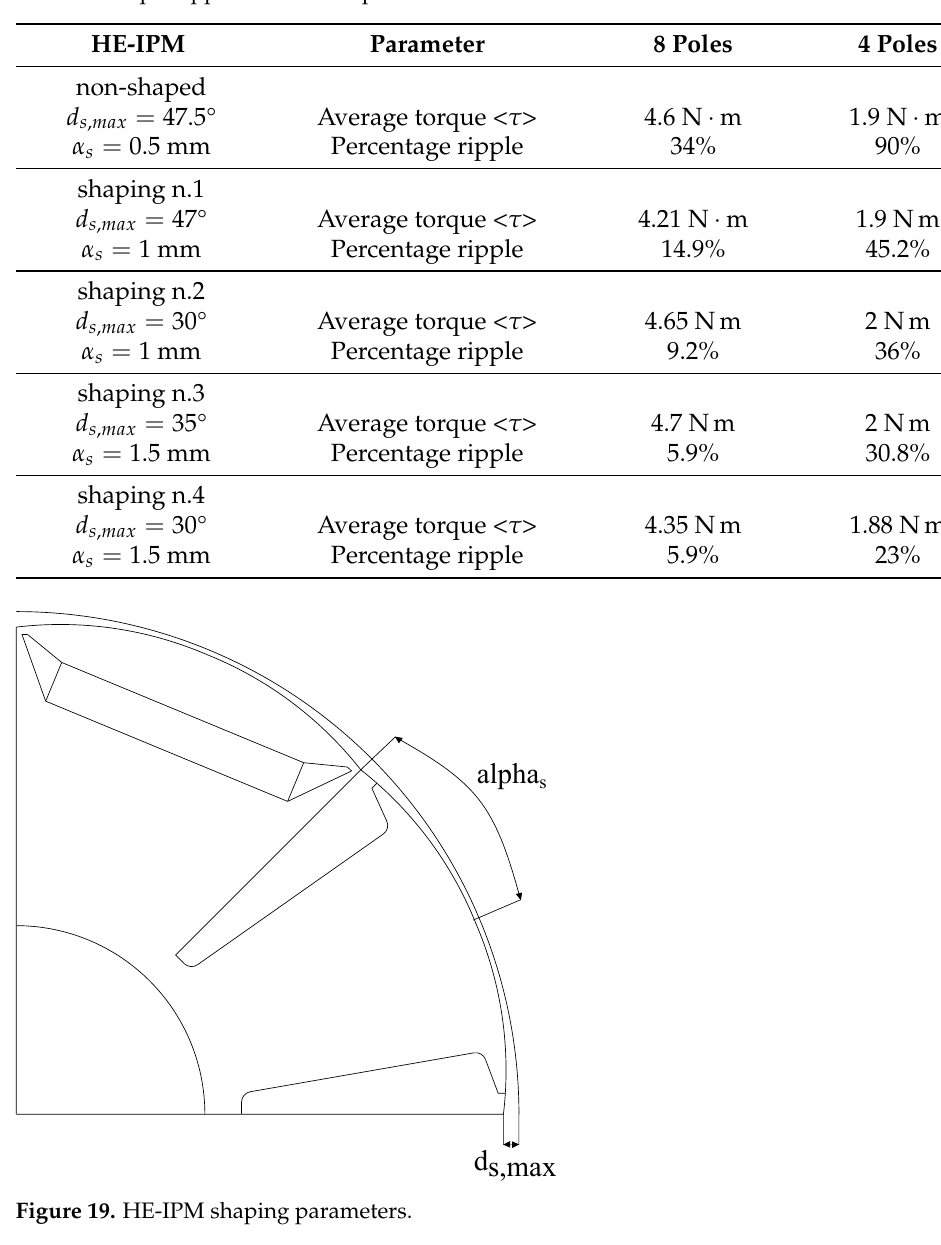
Table 3. Torque ripple with the shaped rotor solution.